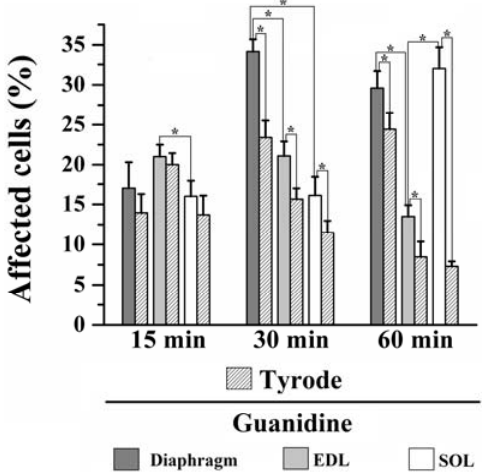
Figure 7. Proportion of affected cells in PND, EDL and SOL muscles after 15, 30 and 60 min of 10 mM guanidine incubation or Tyrode solution (control). One-way analysis of variance (ANOVA) followed by Tukey test, * P ≤